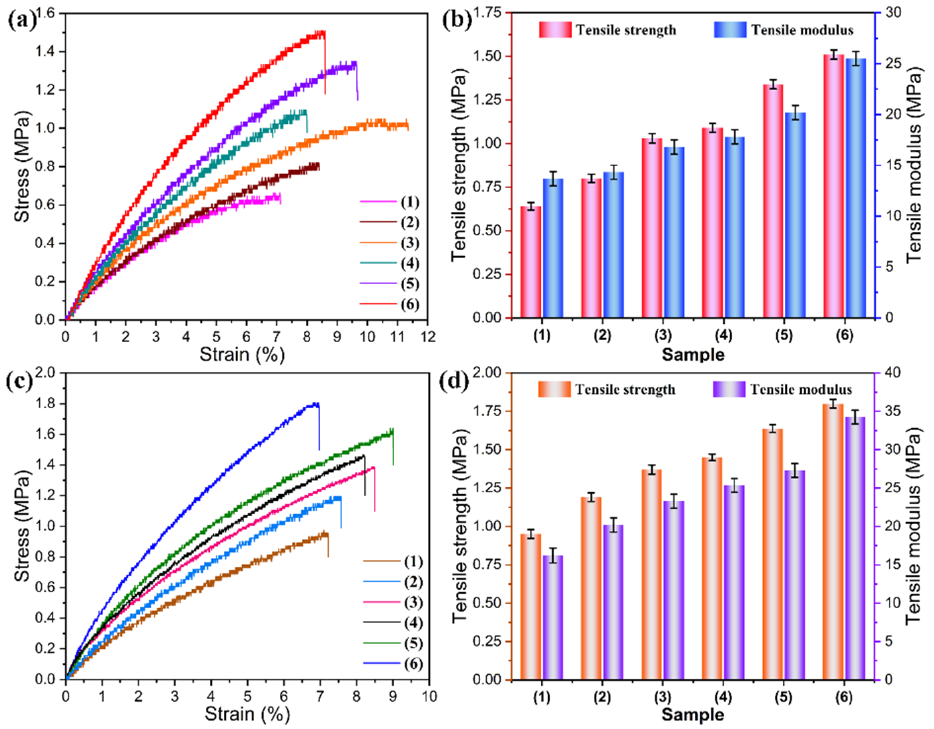
Figure 10. ( a ) Stress–strain curves and ( b ) tensile properties of (1) pure PI aerogel film and PI/graphene/Fe 3 O 4 hybrid aerogel films with a graphene content of 5 wt% and different Fe 3 O 4 contents of (2) 0, (3) 2, (4) 4, (5) 6, and (6) 8 wt%. ( c ) Stress–strain curves and ( d ) tensile properties of (1) PI aerogel/PEG composite film and PI/graphene/Fe 3 O 4 aerogel/PEG composite films with a graphene content of 5 wt% and different Fe 3 O 4 contents of (2) 0, (3) 2, (4) 4, (5) 6, and (6) 8